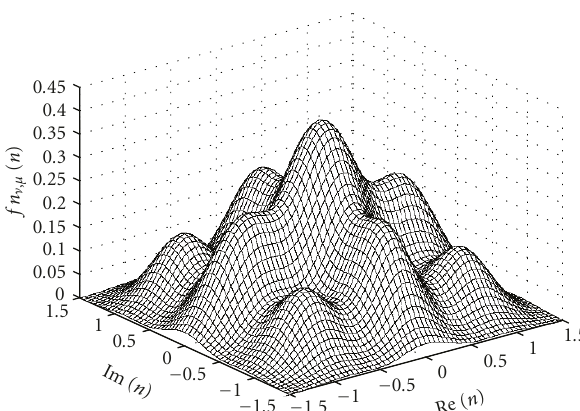
Figure 4: Approximation of actual pdf of ISI, MAI, and noise for ( E b / N 0 ) = 10dB. 10log 10